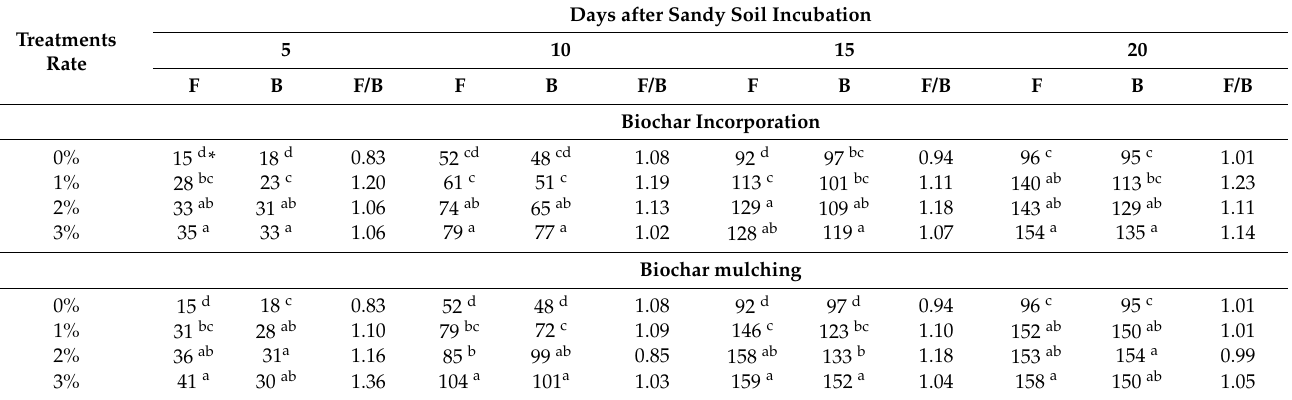
Table 10. Total count of bacteria (B) [ × 10 6 cfu g − 1 ] and fungi (F) [ × 10 4 cfu g − 1 ] and soil Fun- gal/Bacterial (F/B) ratio in sandy soil amended with corncob biochar irrigated with Al-Moheet drainage